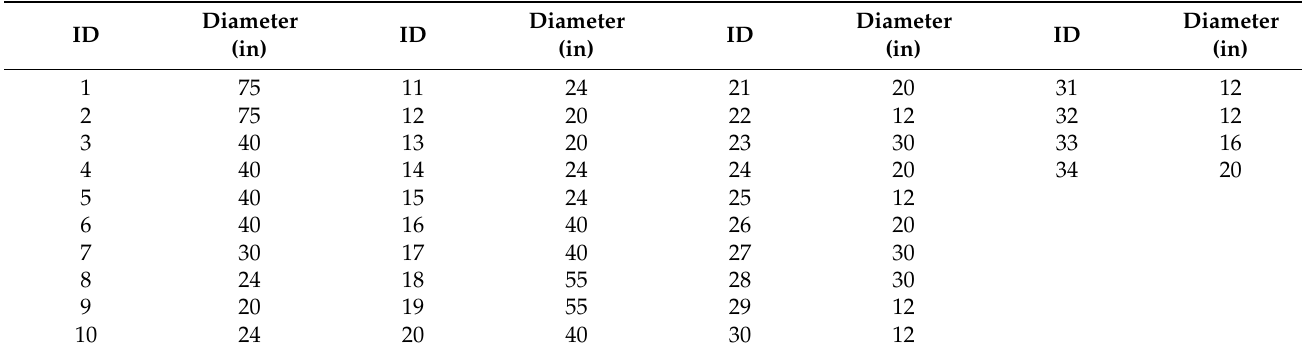
Table 6. Results for the Hanoi network. Table 7. Best solution for the Hanoi